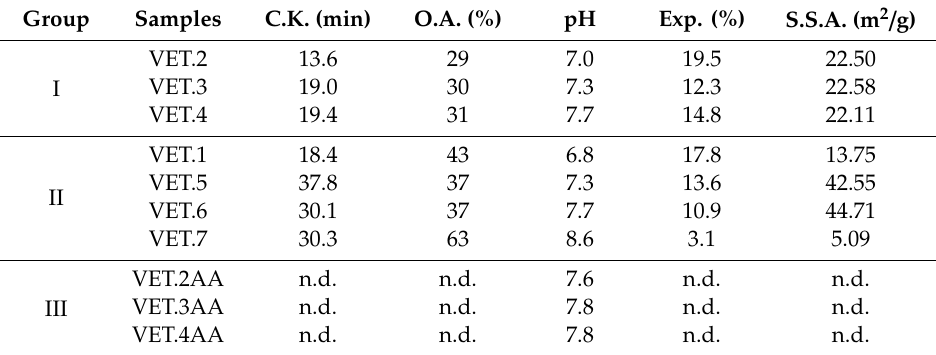
Table 5. Main physical and technological properties of the studied samples (Cont.).